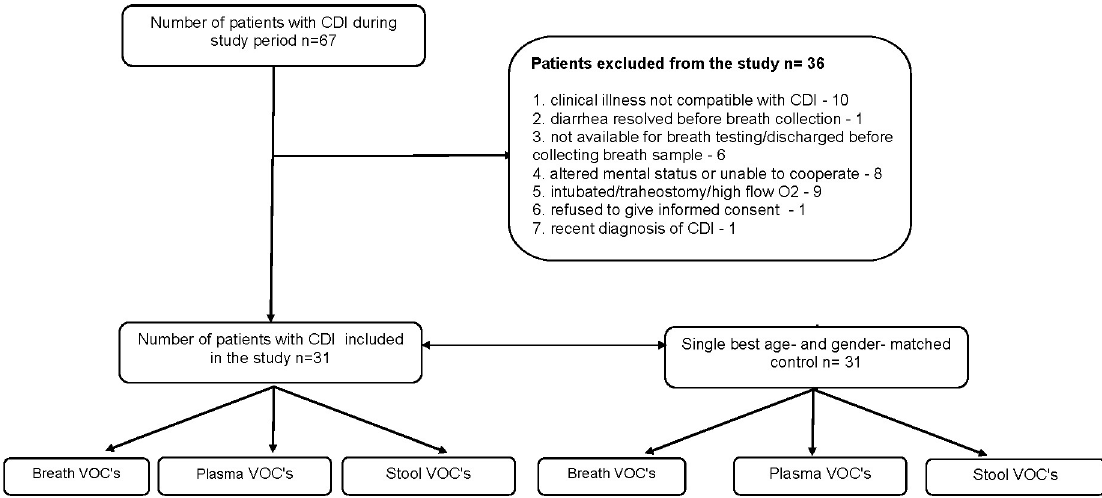
Fig 1. Study flow chart. Flow chart showing the number of patients screened, patients included, and their comparison to age- and gender- matched controls.